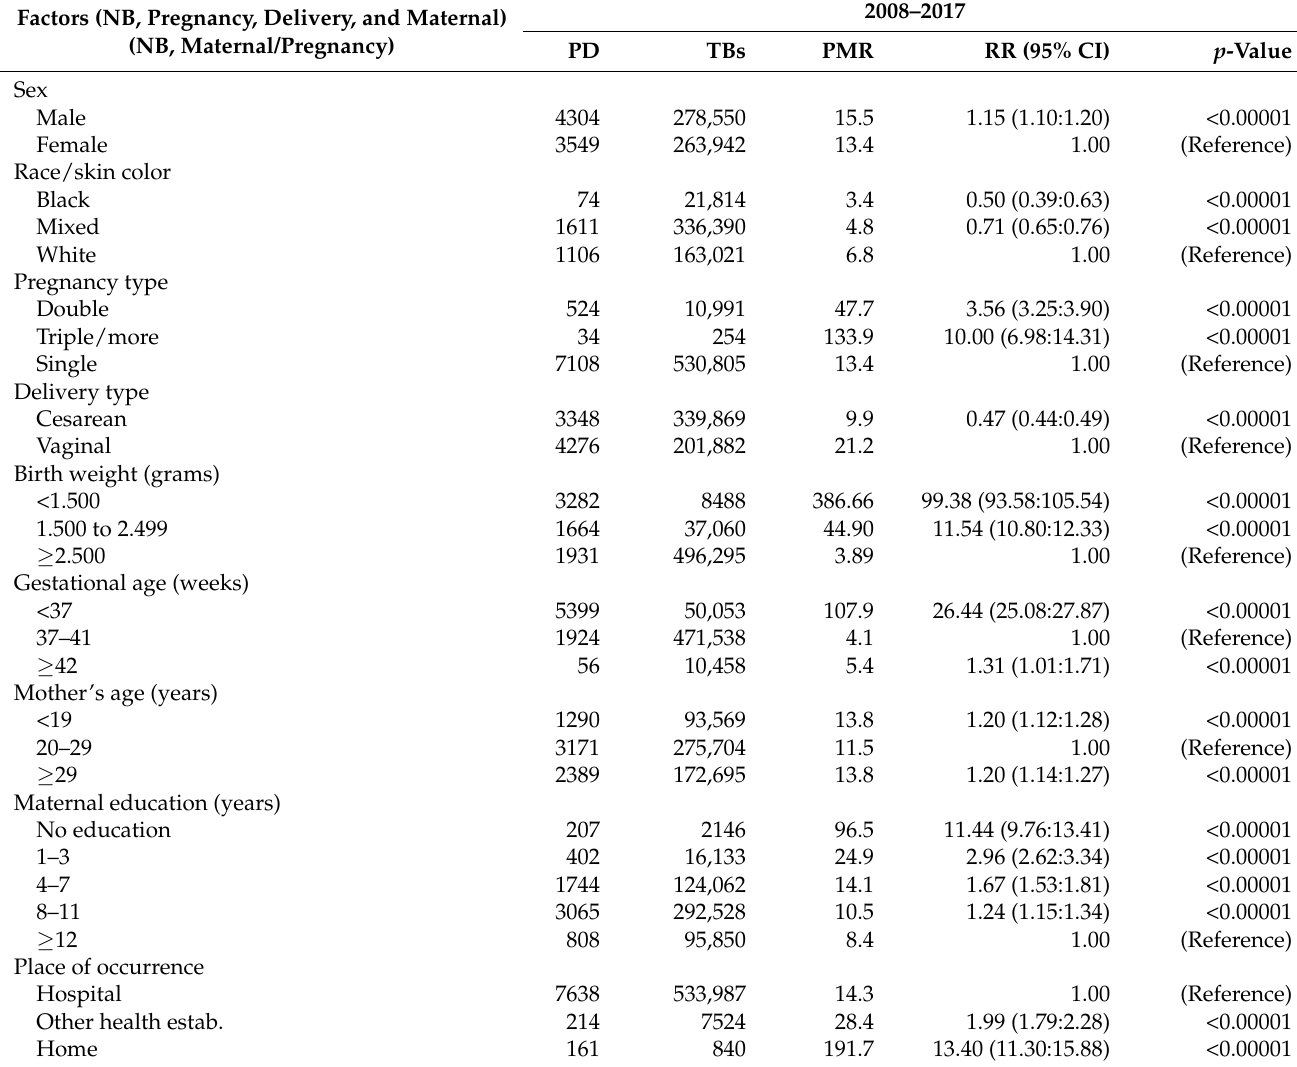
Table 4. Factors associated with risk of perinatal complications, according to maternal, pregnancy, and the newborn’s characteristics in the state of Esp í rito Santo, Brazil,